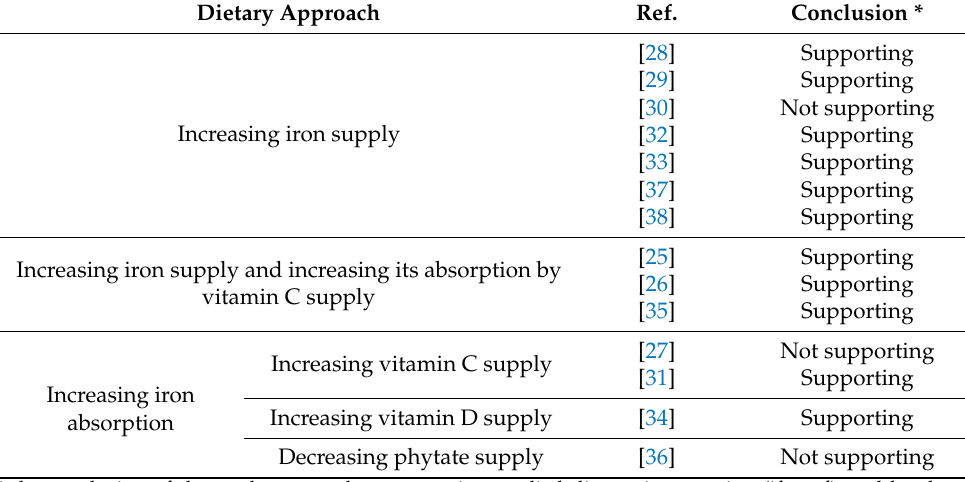
Table 6. The summary of conclusions from the randomized controlled trials included in the systematic